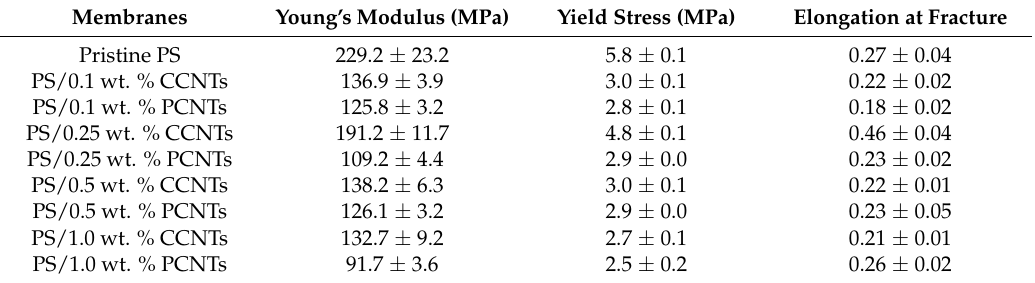
Table 3. Mechanical behaviors of PS nanocomposite membranes with different contents of CCNTs or PCNTs at room temperature and at an initial strain rate of